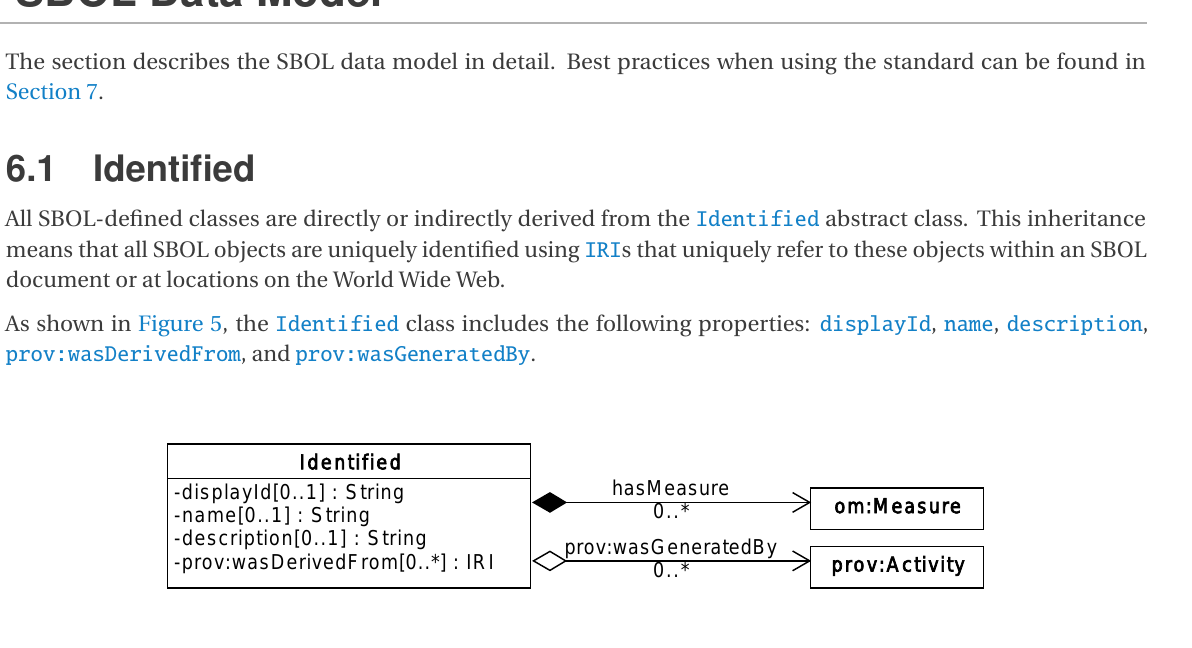
Figure 5: Diagram of the Identified abstract class and its associated